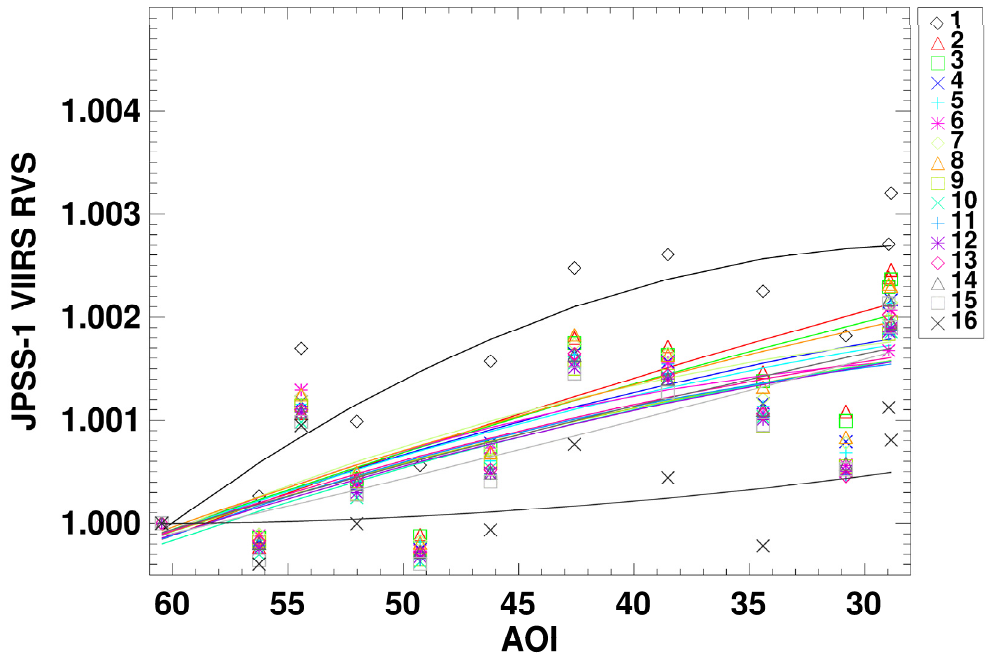
Figure 7. DNB HAM side A RVS and Fits for all Detectors. Table 5. Maximum RVS Variation across Scan and Characterization Uncertainty for all RSBs.